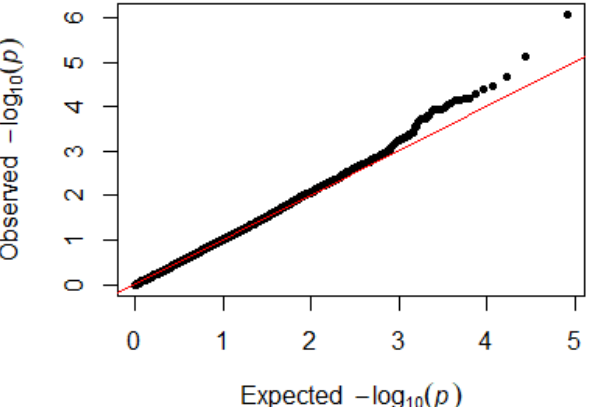
Figure 3. Quantile–quantile plots of p -values for lymphocytes. The x-axis is the expected − log10 p -value and the y-axis is the observed − log10 p -value.